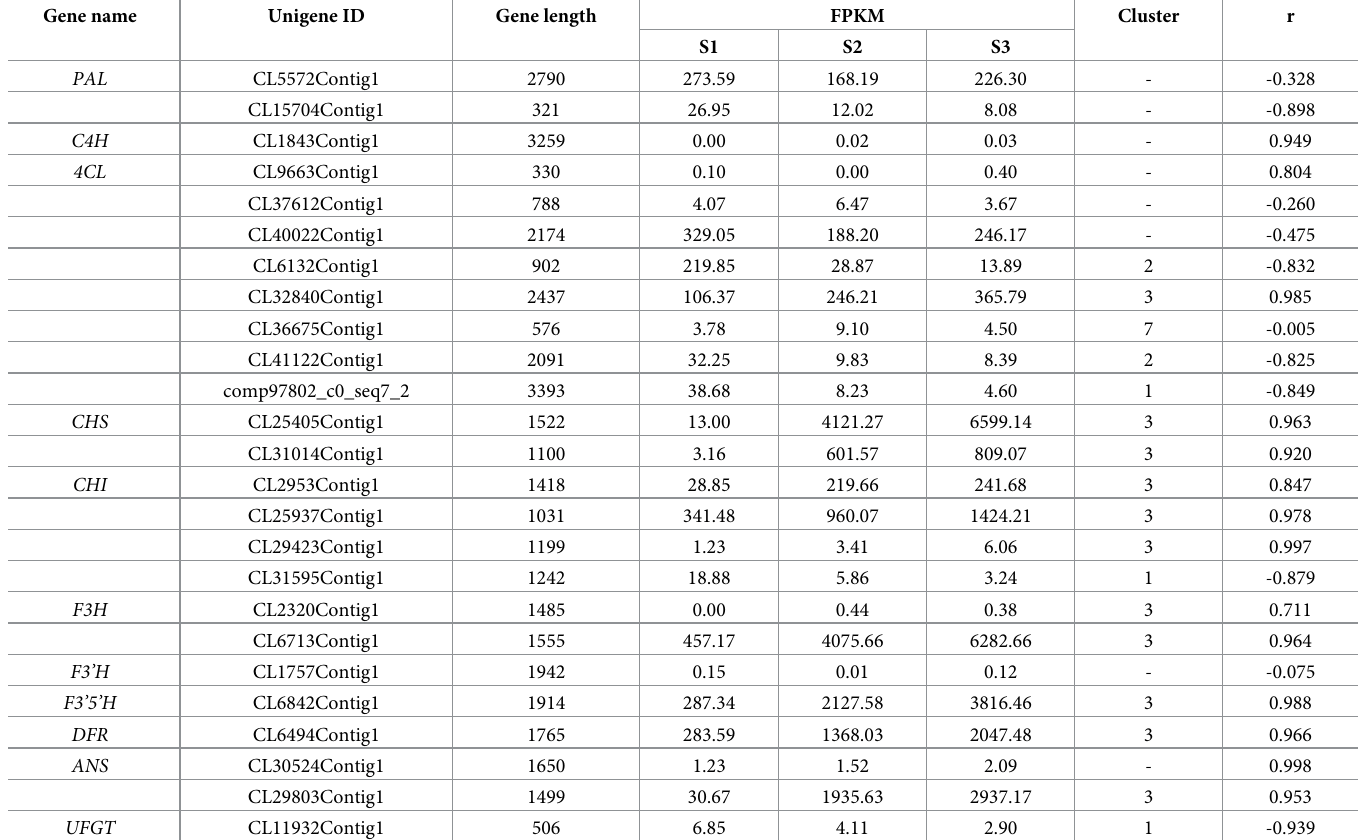
Table 2. Expression profiles, clusters distribution, and correlation analysis of the structural genes related to anthocyanin biosynthesis in L . ruthenicum fruit ripe- ness. “r” represents the Pearson correlation coefficient between structural genes and anthocyanin contents in different developmental fruits. Gene